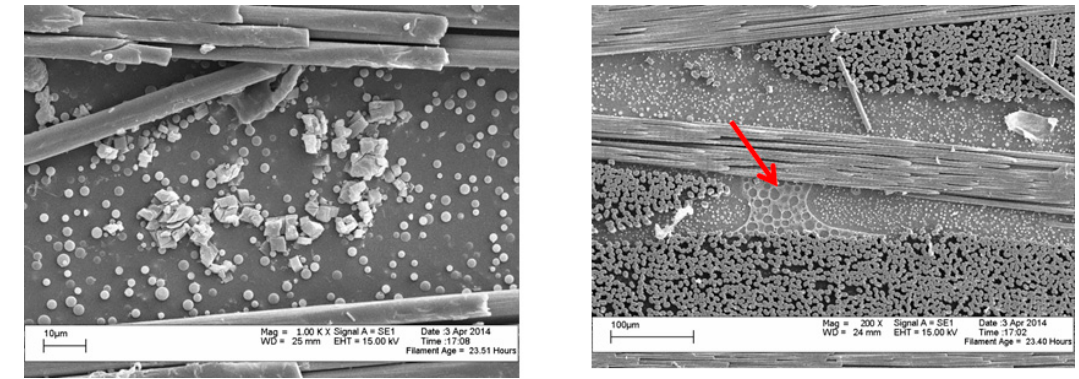
Figure 13. SEM of the laminate with the coPES/10% POSS veil dissolved in it: High resolution (1000×, sx) and low resolution (200×, dx).